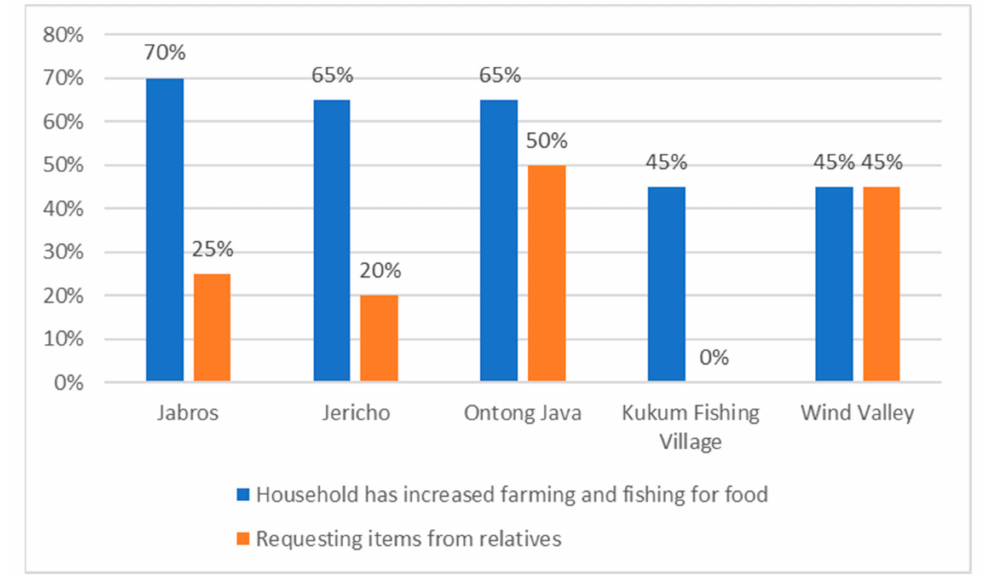
Figure 4. Traditional forms of social protection by settlement (Data from